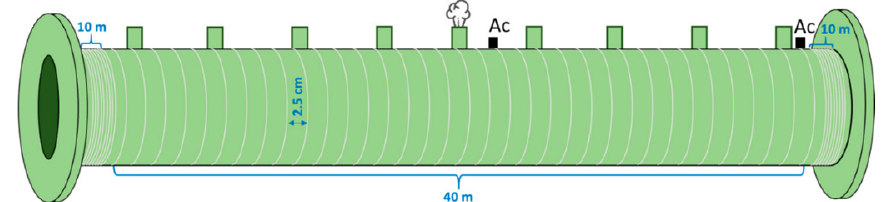
Figure 14. Schematic illustration of the employed fiber helically wrapping around the pipe to monitor leak-induced vibrations based on distributed acoustic sensing (DAS)